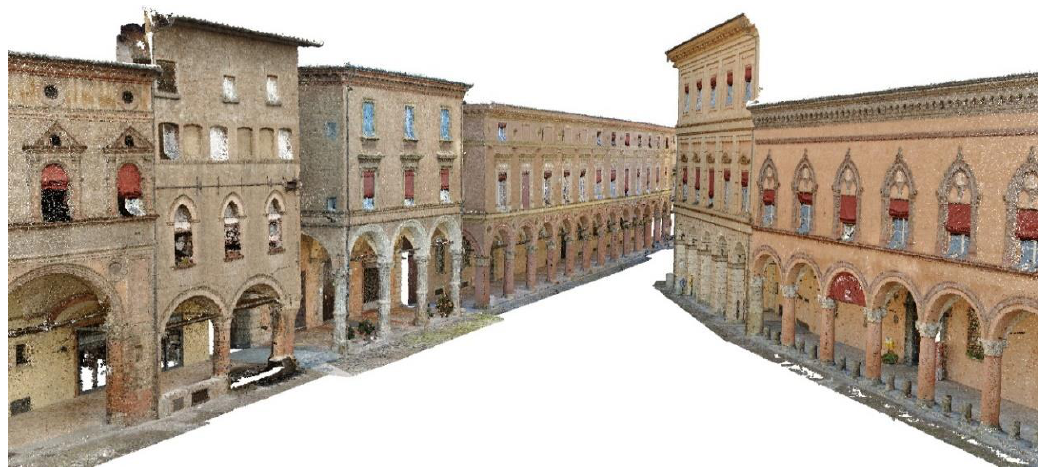
Figure 3. A closer view of the reference dataset, where it is possible to see the big variety of the architectural elements (facades, windows, arches, doors, columns,